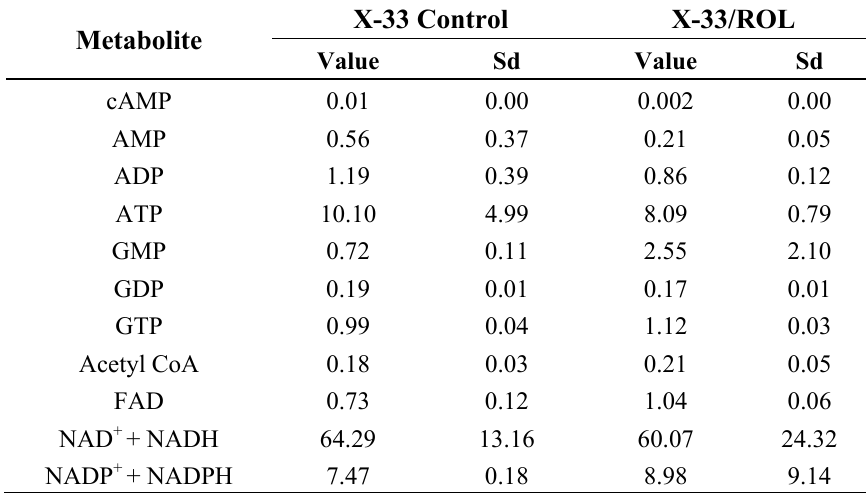
Table 2. Intracellular concentrations of nucleotides and coenzymes in P. pastoris cells growing on glucose/methanol. Concentrations are given in  mol/g